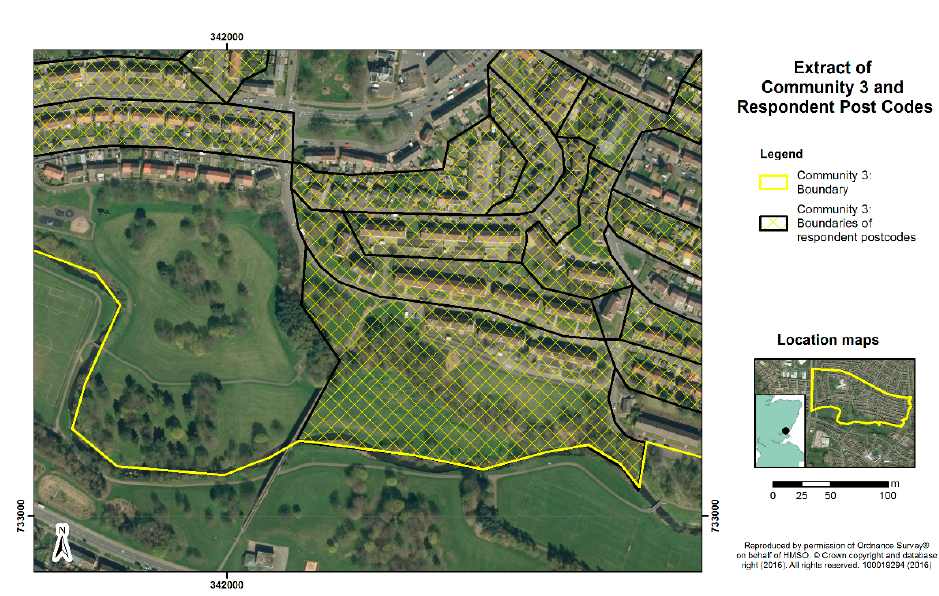
Figure 3. Aerial view of typical residential neighbourhood in Community 3.